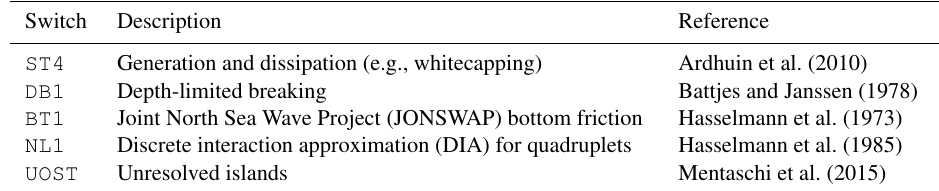
Table 2. WW3 physics switches